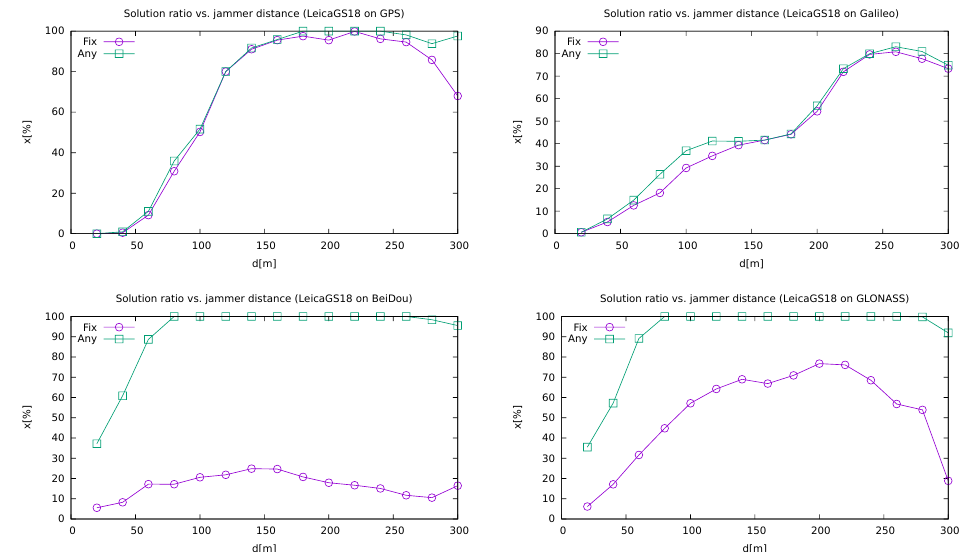
Figure 11. Quality reporting depending on the jammer distance (non-cumulative) on Leica GS18T when using different single satellite systems (own study, from the collection [43]).